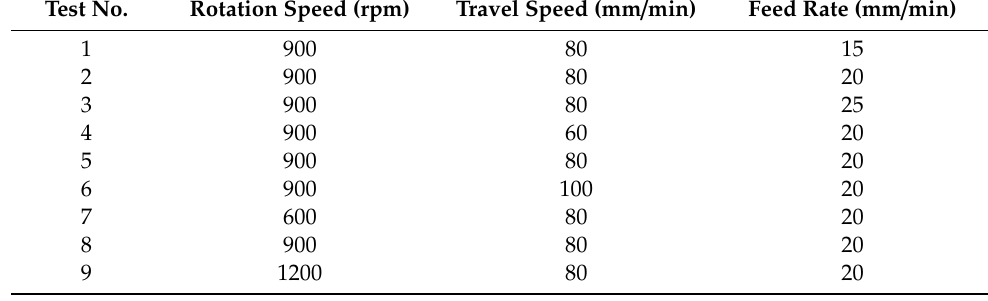
Table 3. Summary of process parameters.